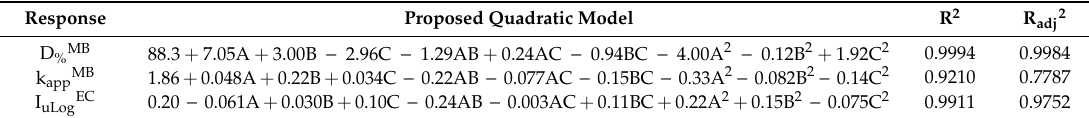
Table 3. Statistical results of the proposed models in terms of the coded